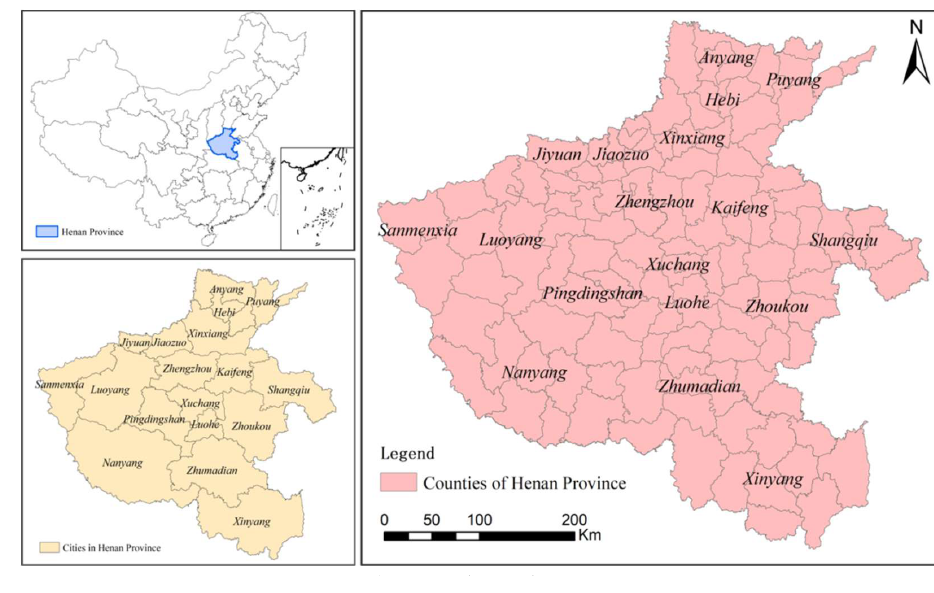
Figure 2. The study area.